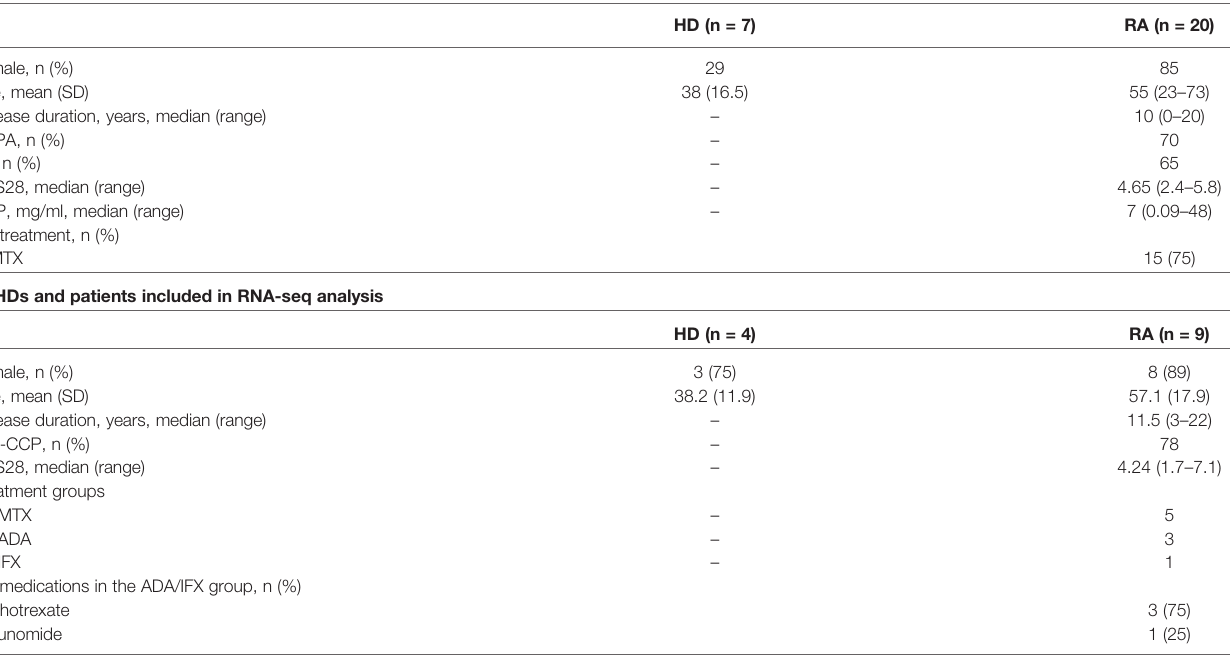
TABLE 1 | Demographic and clinical data. A. Healthy donors (HDs) and ABIRA patients with rheumatoid arthritis